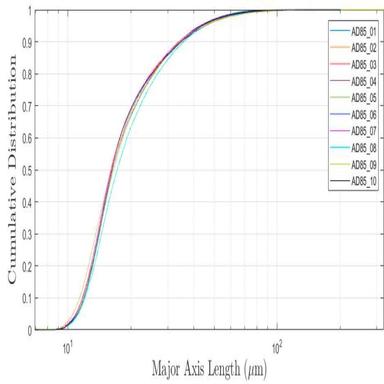
Cumulative distribution function plot of the major axis length for all 10 AD85 samples.